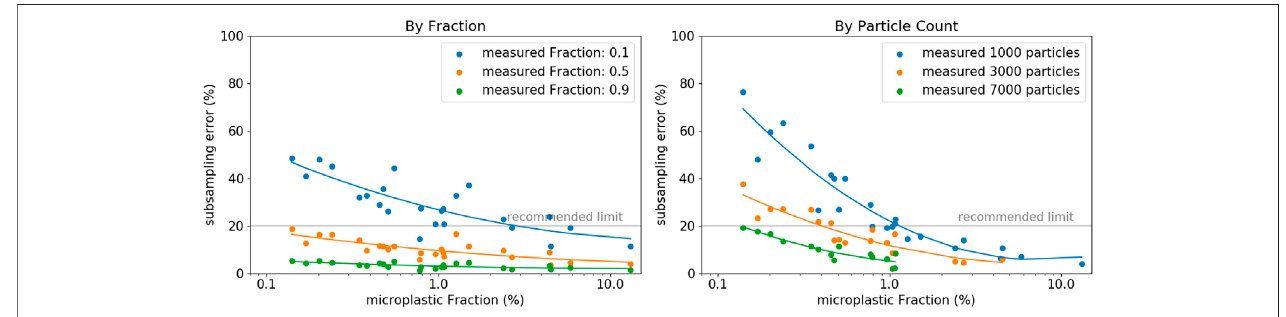
FIGURE 5 | Compilation of the individual errors of each sample (each representing an average of 10 iterations per sample) as a function of the MP fraction with a color-coding representing (A) the measured fraction of particles or (B) a distinct particle count, respectively (random particle